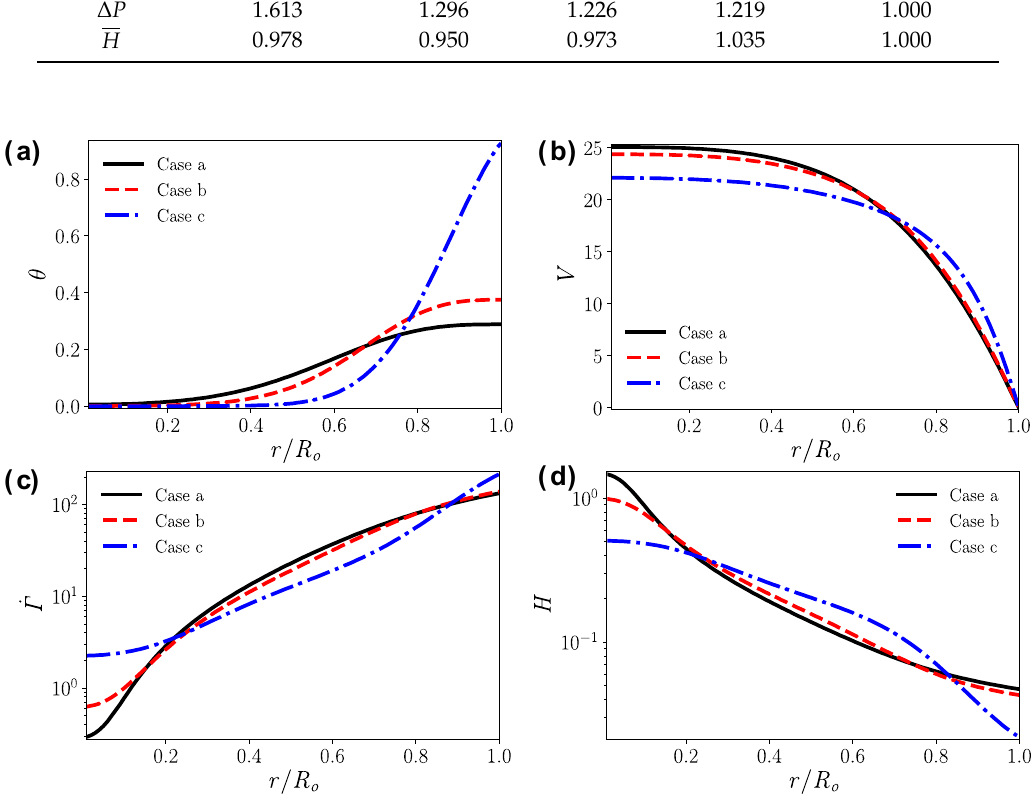
Figure 14. The dimensionless ( a ) temperature, ( b ) velocity, ( c ) shear rate and ( d ) apparent viscosity profiles in the radial direction for different heating positions. The inlet mean velocity, mean shear rate and mean apparent viscosity when θ w = 1 and Re gen = 2.3 × 10 − 2 are used as reference parameters. Table 3. Effects of heating conditions on the pressure drop and the outlet mean apparent viscosity. Non-heated Case a Case b Case c All-heated ∆𝑃 1.613